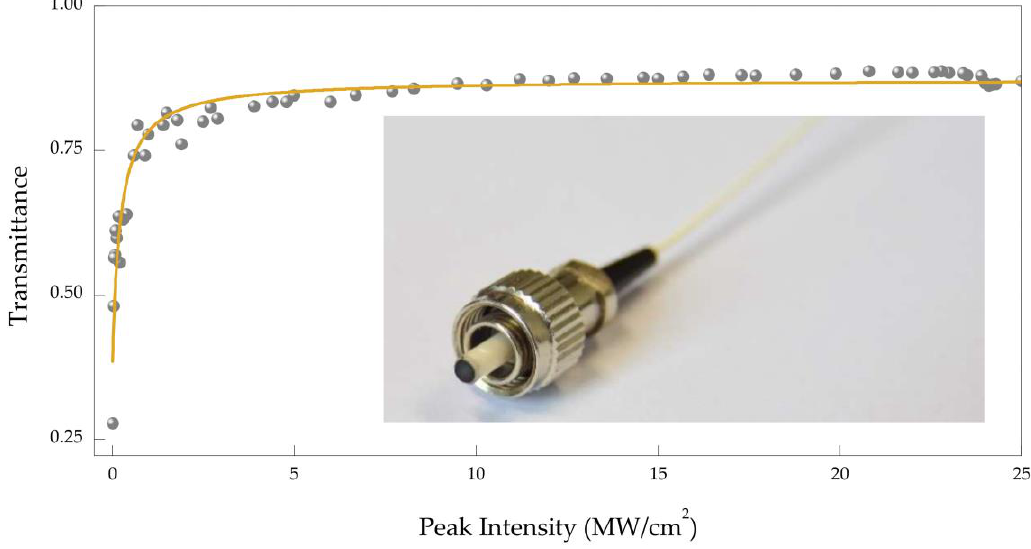
Figure 2. Nonlinear saturable absorption curve of PbS QDs saturable absorber (SA). Inset: PbS QDs mode